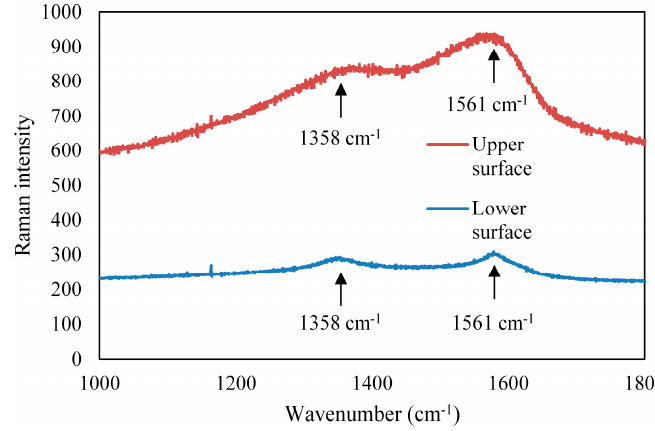
Figure 11. Raman spectra of a point on the groove wall.